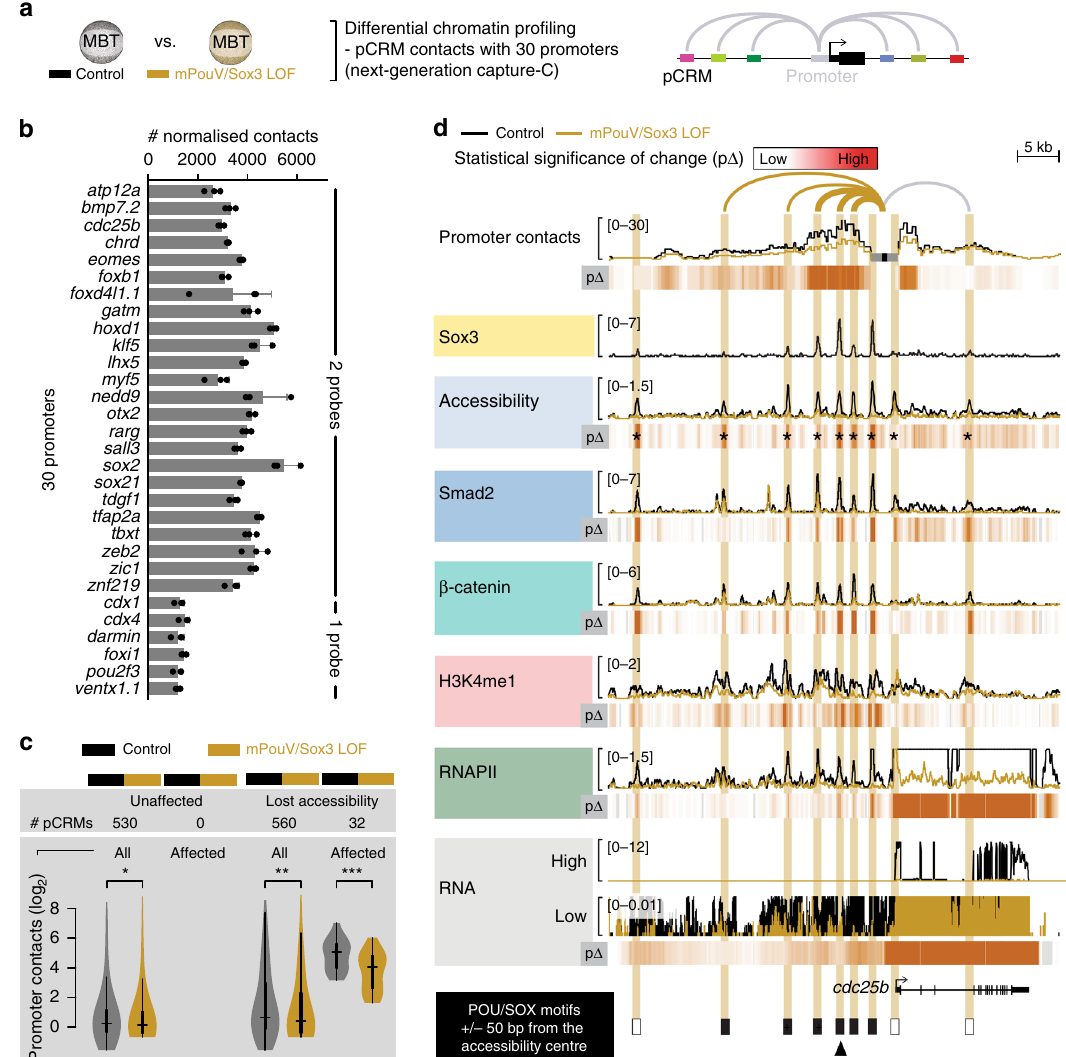
Fig. 9 Pioneering activity of mPouV/Sox3 initiates extensive chromatin remodelling, such as the chromatin looping of distal pCRMs with promoters. a Used approach to reveal the effect of mPouV/Sox3 on chromatin conformation between 30 promoters and distal pCRMs (next-generation capture-C; n = 3 biologically independent samples) at the MBT. b Bar graph shows the number of normalised promoter contacts (mean + s.d.; n = 3 biologically independent samples) derived from non-redundant capture-reporter FLASH 88 reads (Supplementary Fig. 12b) for each promoter captured with one or two probes under control condition (Supplementary Data 10). c Violin plots compare the number of promoter contacts with accessible pCRMs between uninjected and mPouV/Sox3 LOF embryos. The comparison is strati fi ed into pCRMs with stable and lost accessibility upon mPouV/Sox3 LOF and shown for both all and affected (FDR ≤ 10%) promoter contacts. Wilcoxon tests and effect size estimates: * p = 5 × 10 – 5 and r effect = 0.12 (small effect); ** p = 5 × 10 − 30 and r effect = 0.34 (medium effect); and *** p = 5 × 10 − 10 and r effect = 0.78 (large effect). d Superimposed line tracks show promoter contact frequencies, chromatin accessibilities and DNA occupancies of various chromatin components (Smad2, β -catenin, H3K4me1 and RNAPII) at the cdc25b gene locus between control (uninjected) and mPouV/Sox3 LOF embryos. The RNA track is split into a high (0 – 12) and low (0 – 0.01) expression window. Note that the low-expression window shows that locally transcribed non-coding super-enhancer RNA depend on mPouV/Sox3 as well as the gene cdc25b . Heat maps (p Δ ) below each superimposed line plot show the statistical signi fi cance (Wald test) of changes caused by mPouV/Sox3 LOF. The footer highlights the occurrences of canonical POU/SOX motifs (black fi lled rectangles) at accessible pCRMs (±50 bp from the accessibility centre) and one strongly affected pCRM with an arrowhead. Asterisks on the p Δ heat map mark signi fi cant (FDR ≤ 10%) reductions to pCRM accessibility. pCRMs are boxed in and their frequency of contacts with the cdc25b promoter are illustrated with an arc of varying strength. Boxes of affected pCRM and arcs